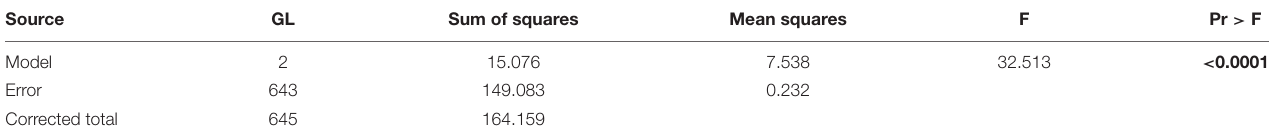
Calculated against the model Y = Mean (Y).